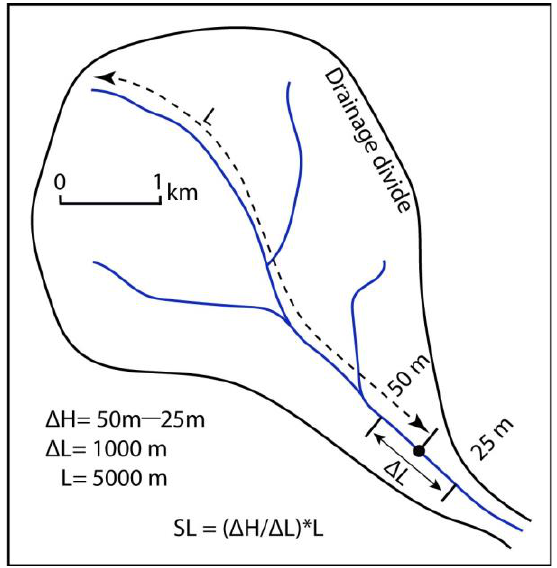
Figure 3. Stream length gradient index scheme (modified from [40]).